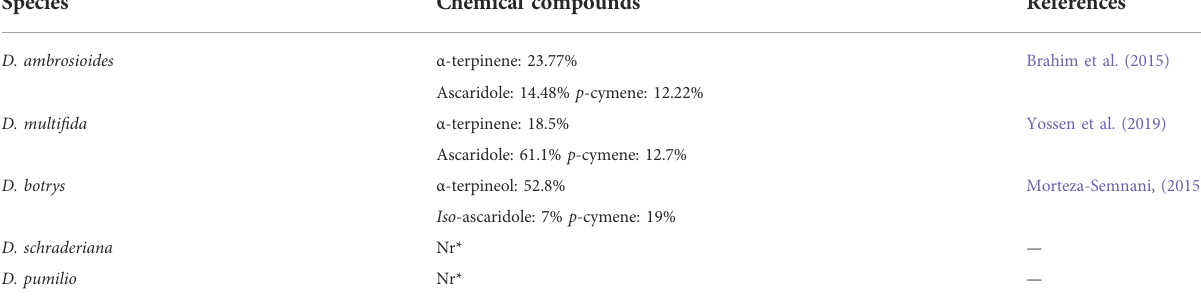
TABLE 3 Chemical composition of Dysphania Spp., plant essential